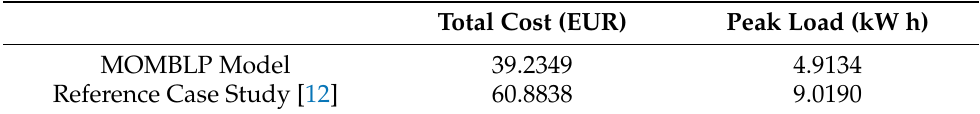
Table 3. Comparison of Proposed Model (MOMBLP) with Reference Case Study for 1 day from external